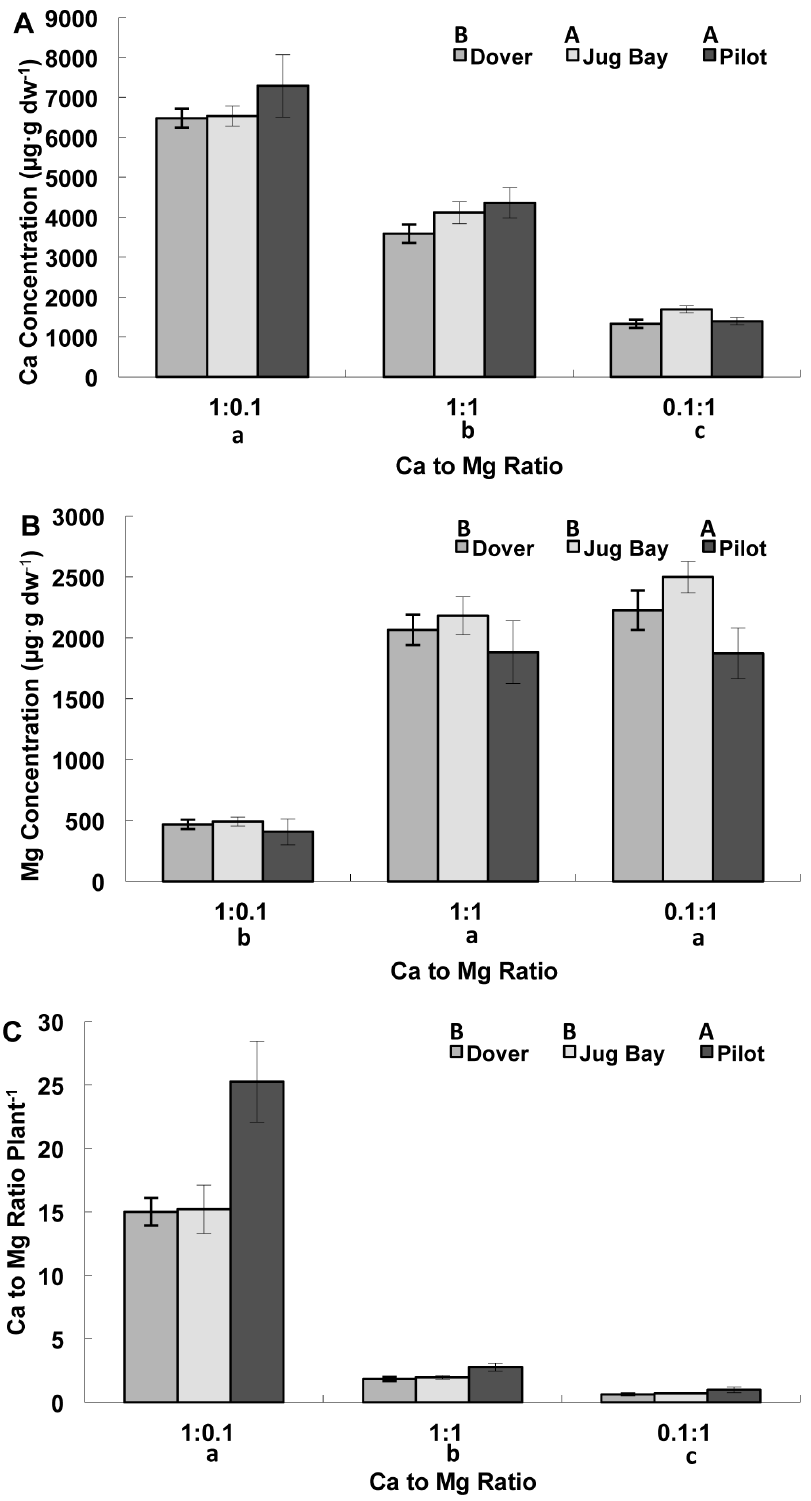
Figure 3. Rosette tissue Ca and Mg concentration of juvenile plants of three A.l. ssp. lyrata populations. A. Rosette tissue Ca concentration , B. Rosette tissue Mg concentration, and C. Rosette tissue Ca to Mg ratio. All data are presented as a mean 6 standard error (n=16). The plants were from serpentine (Pilot), limestone sand (Dover), and sandy loam (Jug Bay) soils. Different upper case letters indicate significant differences among populations, and different lower case letters indicate significant differences among substrate Ca to Mg ratios as separated by Tukey’s HSD (P , 0.05).